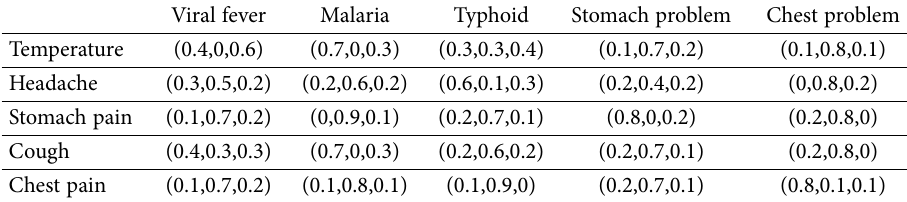
Table 5. Symptoms characteristic for the considered diagnoses